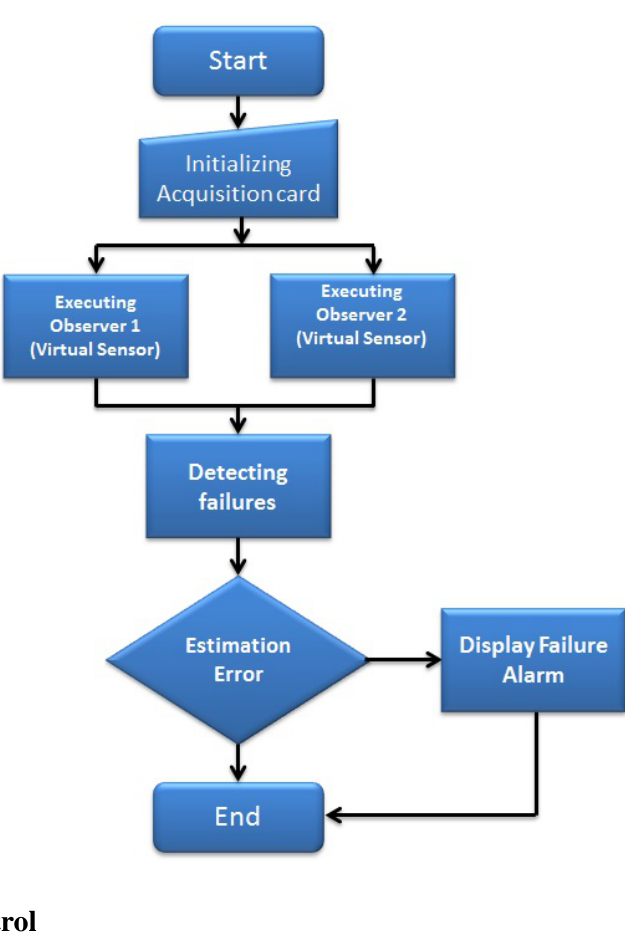
Figure 8. Failure detection